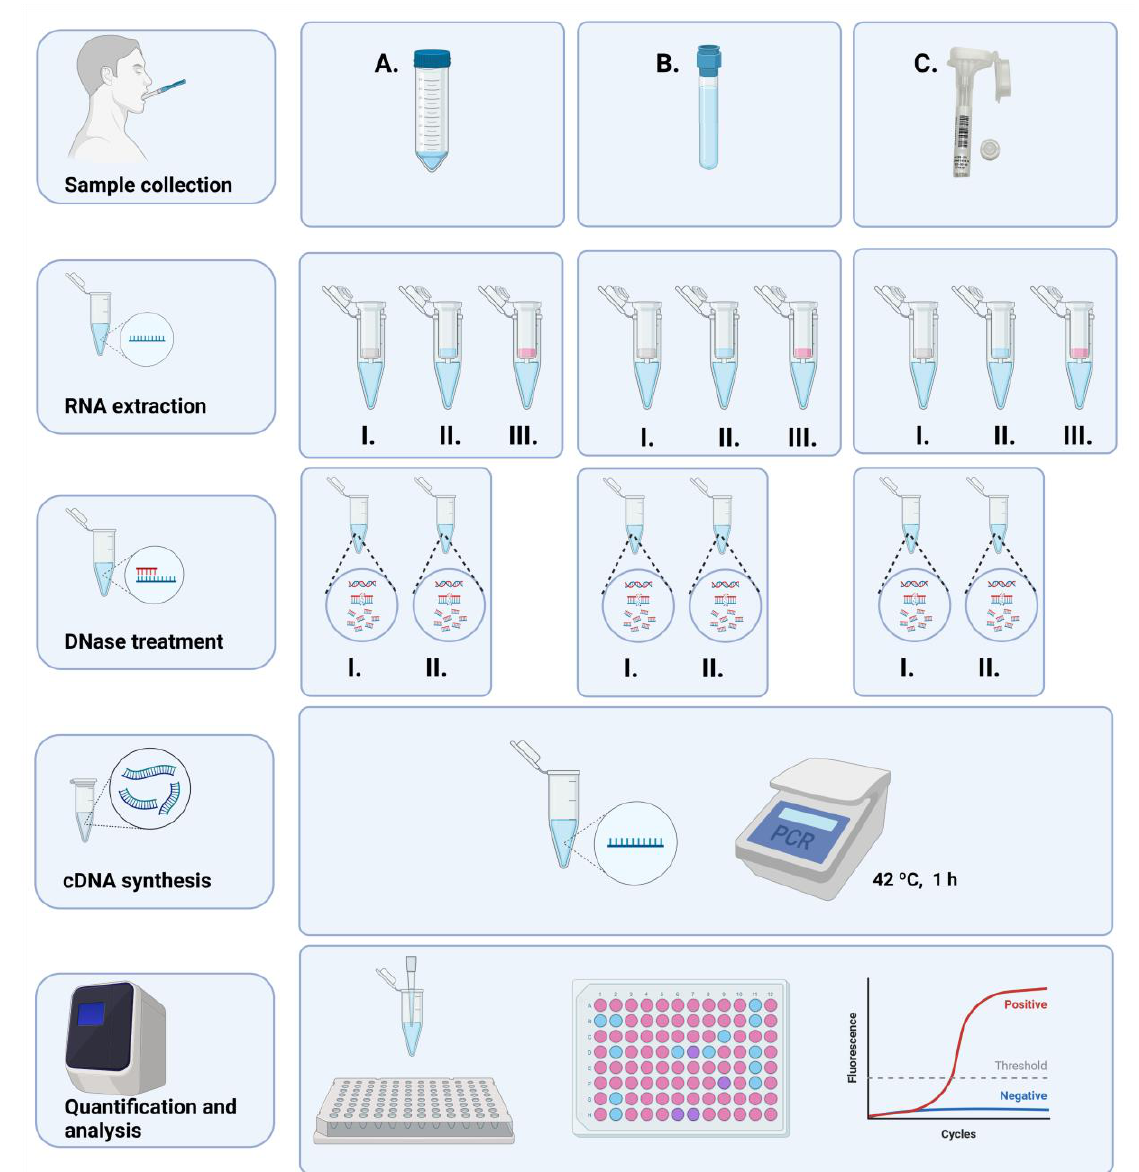
Figure 1. Scheme of the study. In sequential order, from top to bottom, saliva collection (three dif- ferent collectors, ( A ) 50 mL tubes, ( B ) Salimetrics, ( C ) Oragene), RNA extraction (three different